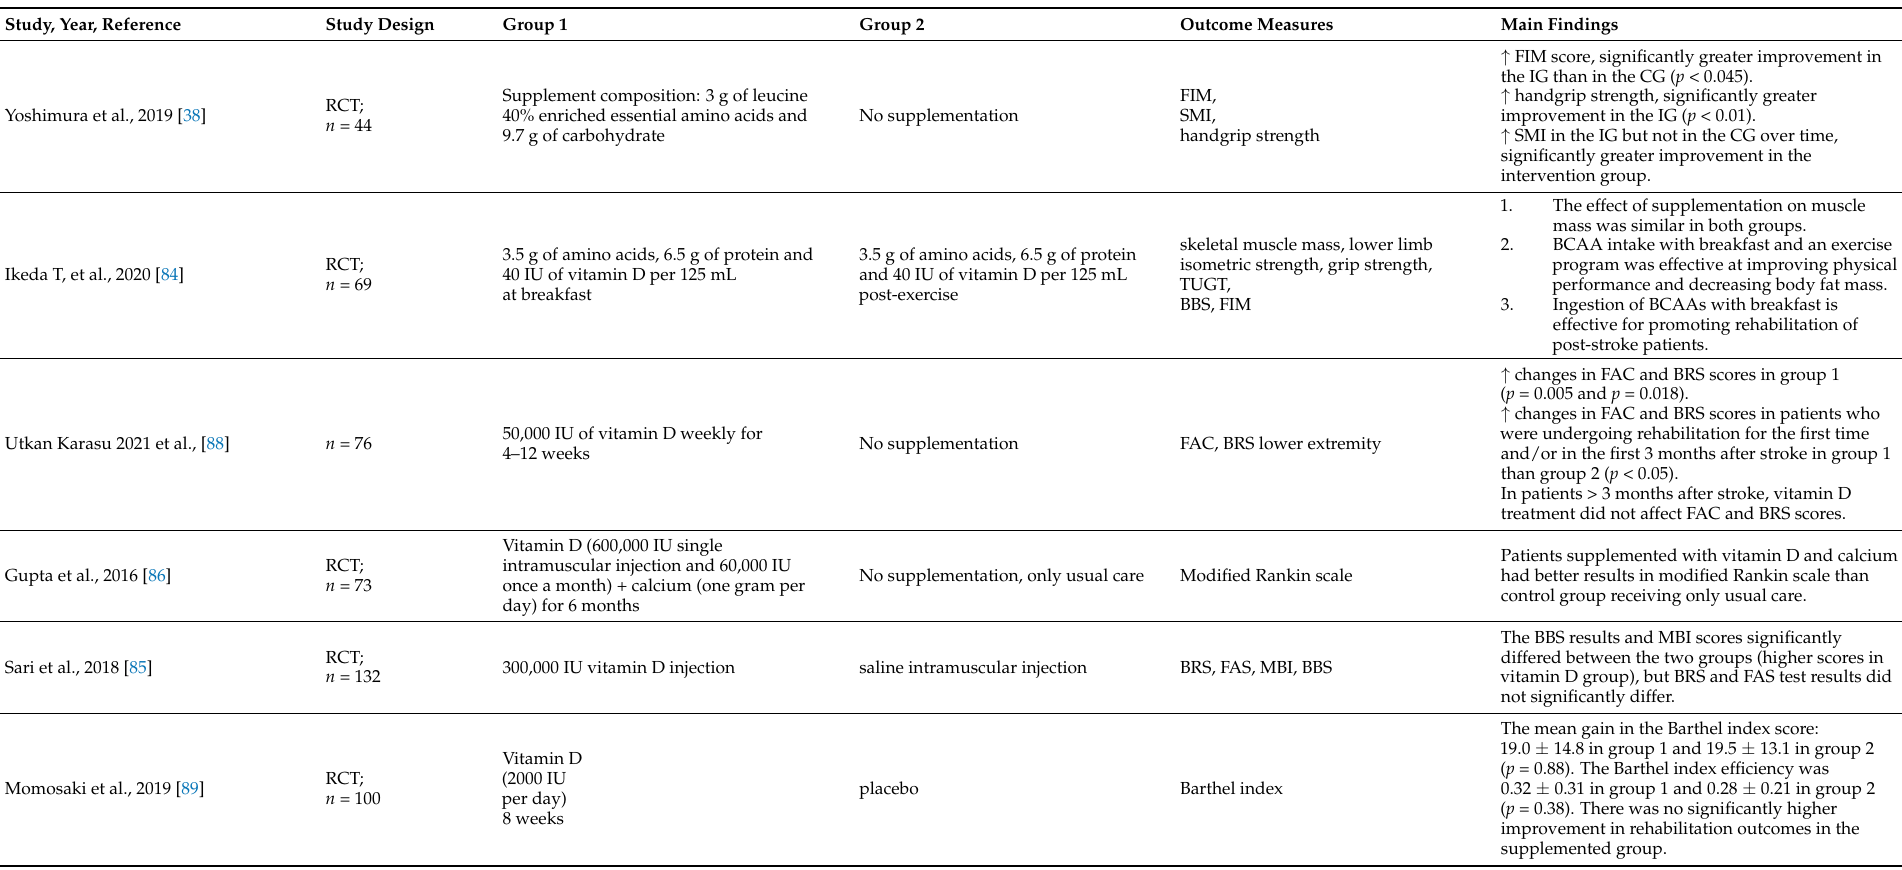
Table 2. The correlation between supplementation and functional recovery during